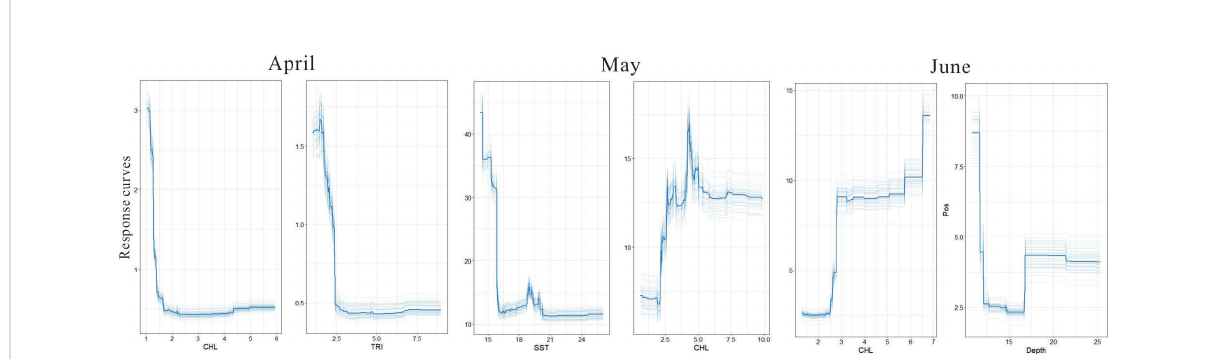
FIGURE 6 Response curves of the two most related environmental factors on the egg distribution of the small yellow croaker from April to June by repeating SAM execution 50